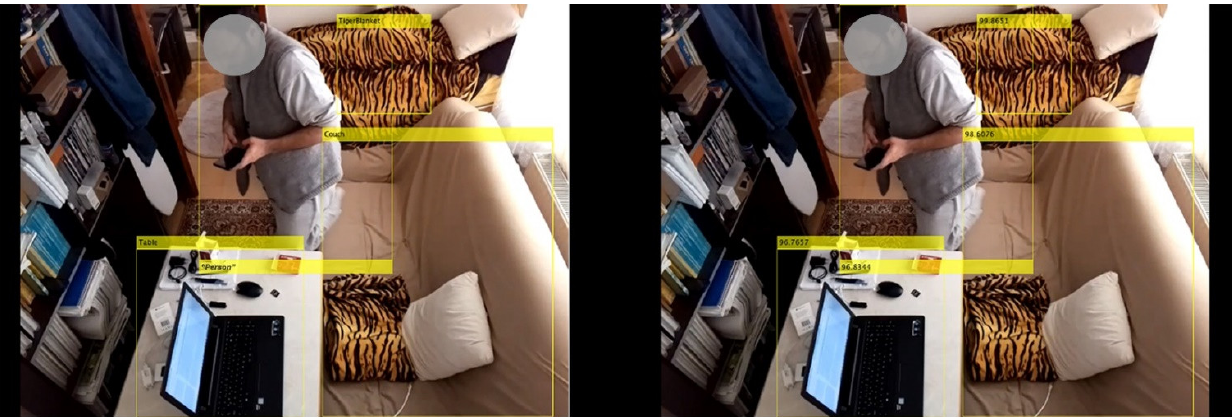
Figure 13. Fast R-CNN model is deployed for labeling the objects and people in the experiment room with the installation of Raspberry Pi 4 & V2 Camera. Accuracy results with true labels: Blanket: 99.87%; Coach: 98.61%; Person: 96.83%; Table: 96.77%. The elapsed time for detecting objects and people in this frame is around 9.48 s.